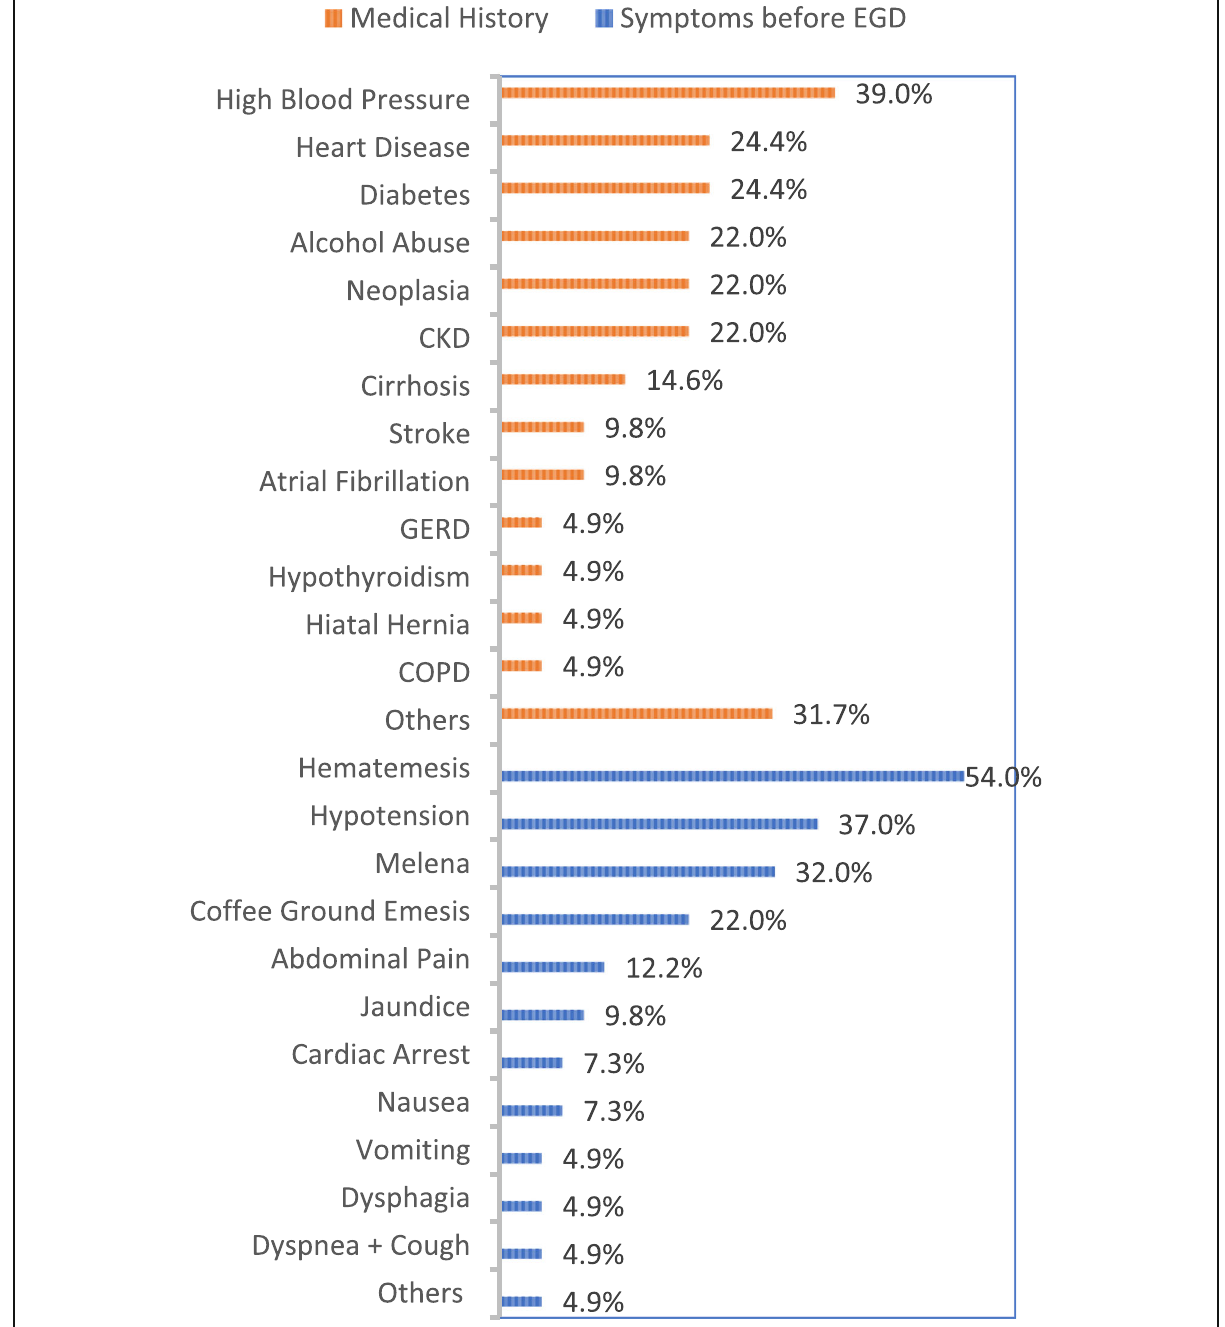
Fig. 3 Figure resuming medical history and symptoms having led to upper endoscopy in the endoscopy series. EGD esogastroduodenoscopy, CKD chronic kidney disease, GERD gastroesophageal reflux disease, COPD chronic obstructive pulmonary disease. Others in symptoms before EGD: acute pancreatitis (1) and hypothermia (1). Others in medical history: abdominal aortic aneurysm (1), thoracic aortic aneurysm (1), asthma (1), diabetic arteriopathy (1), drug abuse (1), diverticulosis (1), lupus erythematosus disseminatus (1), osteoarthritis (1), pancreatitis (recurrent) (1), peripheral vascular disease (1), polyglobulia (1), primary adrenal insufficiency (1), pressure ulcers